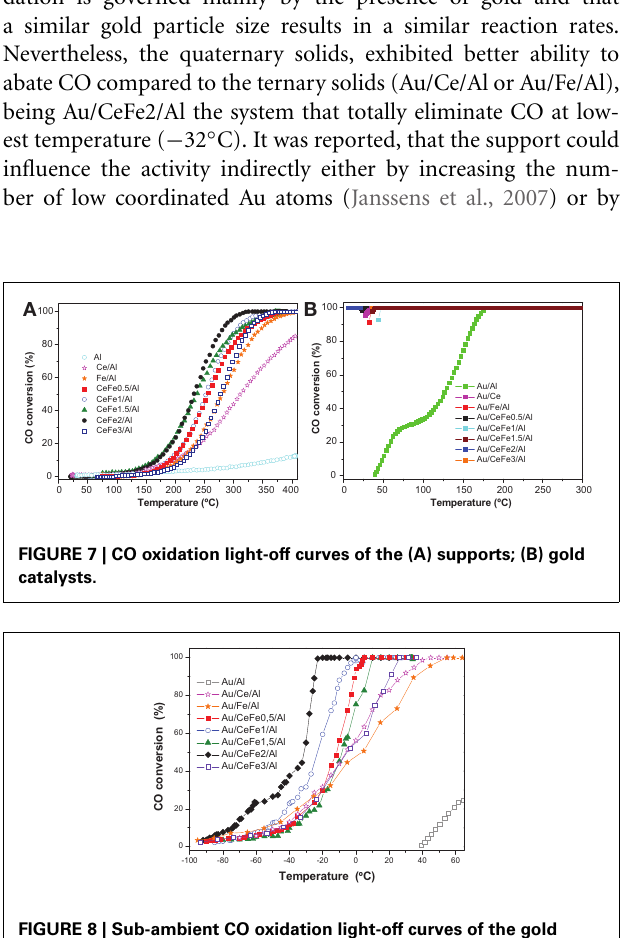
Table 2 | Oxygen storage capacity (OSC) and number of oxygen layers (NL) as a function of the temperature. Sample